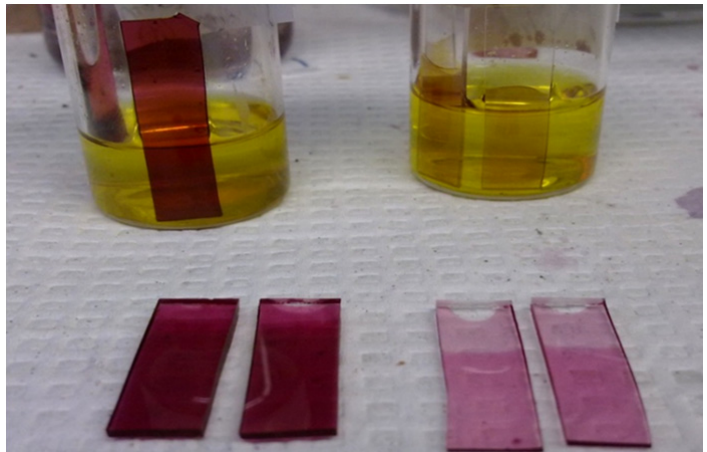
Figure 31. Fabrication of Au-PDMS at the macro-scale.